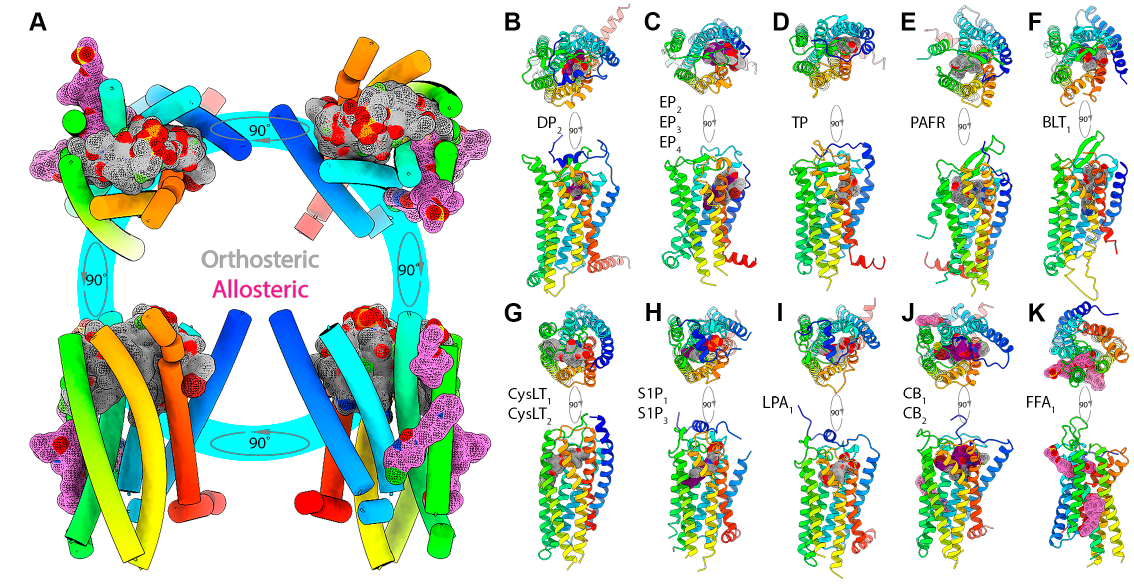
Figure 4. ( A ) Distribution of bound ligands in the orthosteric site (surface mesh representation with carbon, oxygen, ni- trogen, and phosphorus atoms colored grey, red, blue, and orange, respectively) and allosteric sites (pink surface mesh) in a representative lipid receptor structure illustrated using cylinder (helices only) representation. Distribution of bound orthosteric agonists (surface mesh representation with carbon, oxygen, nitrogen, and phosphorus atoms colored purple, red, blue, and orange, respectively) and antagonists (grey surface mesh), and allosteric antagonists (pink surface mesh) bound to structures belonging to ( B ) DP 2 , ( C ) EP 2,3,4 , ( D ) TXA 2 , ( E ) PAFR, ( F ) BLT 1 , ( G ) cysLT 1,2 , ( H ) S1P 1,3 , ( I ) LPA 1 , ( J ) CB 1,2 , and ( K ) FFA 1 .